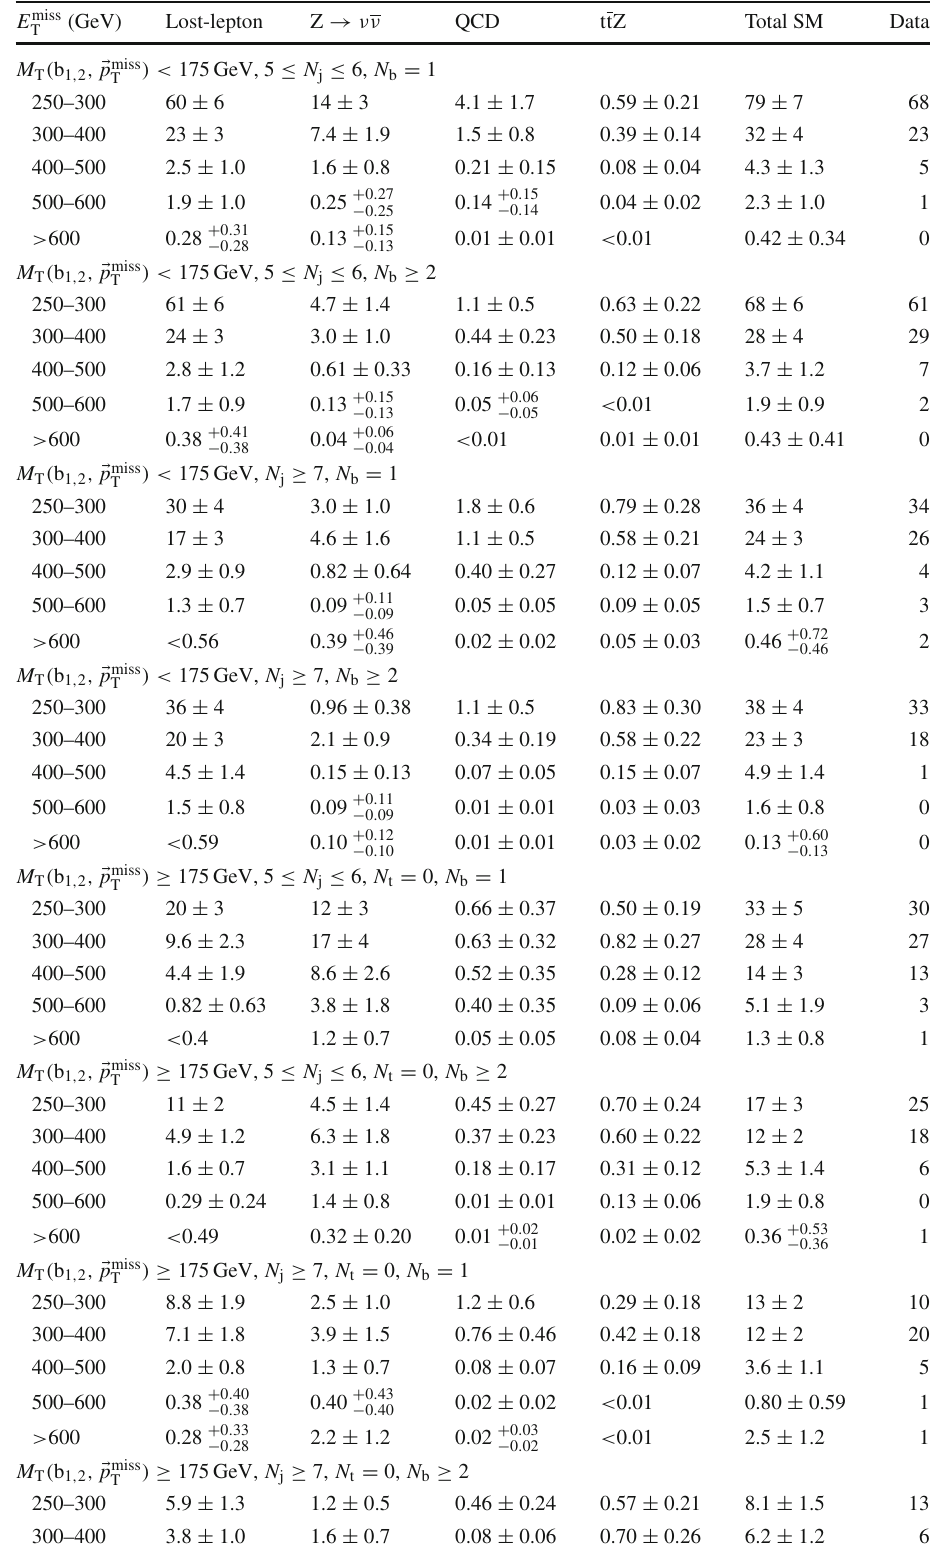
predicted background yields in the different search regions for the top squark search in the all-jet final state. The total uncertainty is given for each background